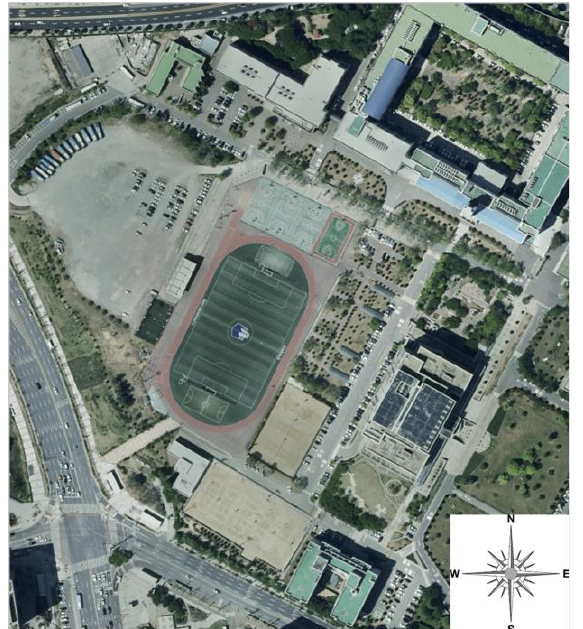
Figure 3. Target area on Inha university